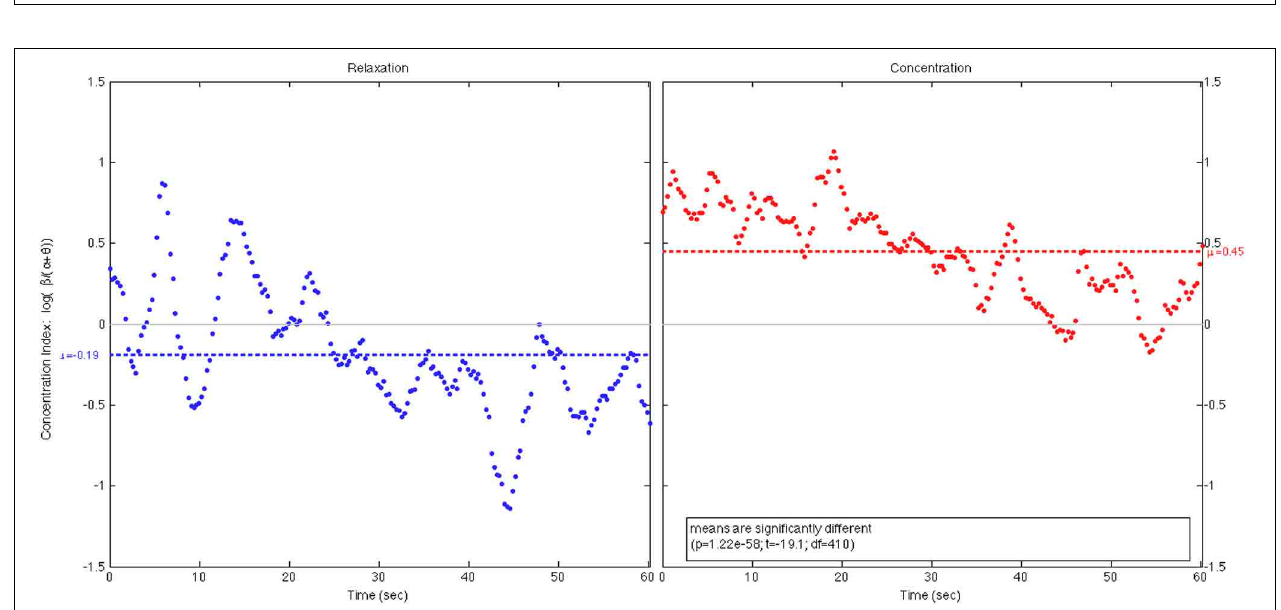
FIGURE 9 | The 1-min plots of a player’s concentration level during a 2-min open- eye relaxation period (left) and an equal-length open-eye concentration period (right).